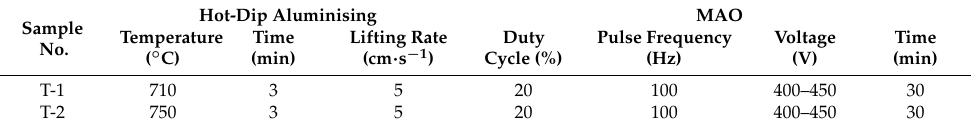
Table 1. Process parameters of hot-dip aluminising and micro-arc oxidation (MAO). Sample